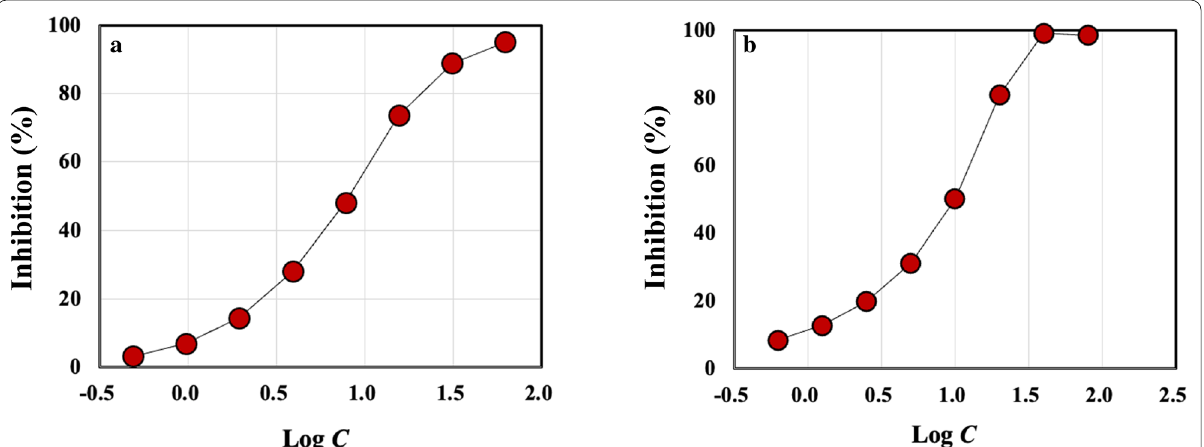
Fig. 3 The inhibitions of the peroxyl radical by a Trolox and b CPH II in percentage as a function of logarithm of the CPH II concentration, C in mg/L